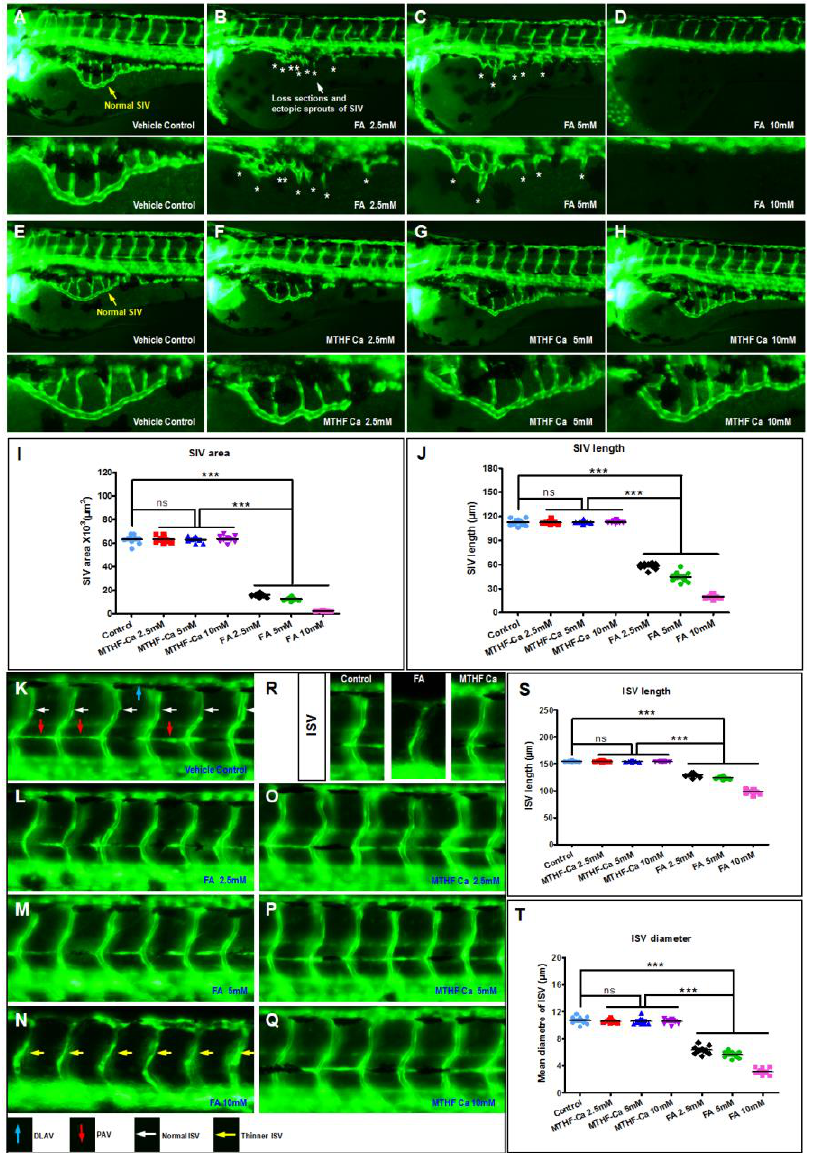
Figure 2. FA, but not MTHF-Ca, regulates vascular development in vivo. ( A – H ) FA, but not MTHF- Ca, impaired formation of zebrafish SIVs in a dose-dependent manner. (( A , E ), yellow arrow) In control embryos, SIVs developed as a smooth, basket-like structure over the yolk at 3 dpf. (( B , C ), asterisks) The embryos treated with FA presented a decreased number of ectopic SIV segments. ( I , J ) Quantification of the area and length of SIVs showed a significant decreased in FA-treated embryos. ( K – R ) The images of trunk regions taken at 3 dpf, with the vascular structures visualized by eGFP fluorescence and labeled ISV and DLAV, showed regular development in the embryo injected with control. ( S , T ) Compared with control or MTHF-Ca-treated groups, FA-treated embryos presented a lower number of incomplete and thinner ISVs (( N ), yellow arrows). In control embryos, PAVs formed normally (( K ), red arrows). Compared with control or MTHF-Ca, FA prevented PAV formation, the precursor to the lymphatic system. FA: folic acid; MTHF-Ca: 6S-5-methyltetrahydrofolate-calcium; DLAV: dorsal longitudinal anastomotic vessel; ISV: intersegmental vessel; PAV: parachordal vessels; SIV: subintestinal vein; dpf: days postfertilization. ns: not significant; *** p < 0.0001; ns: not significant.